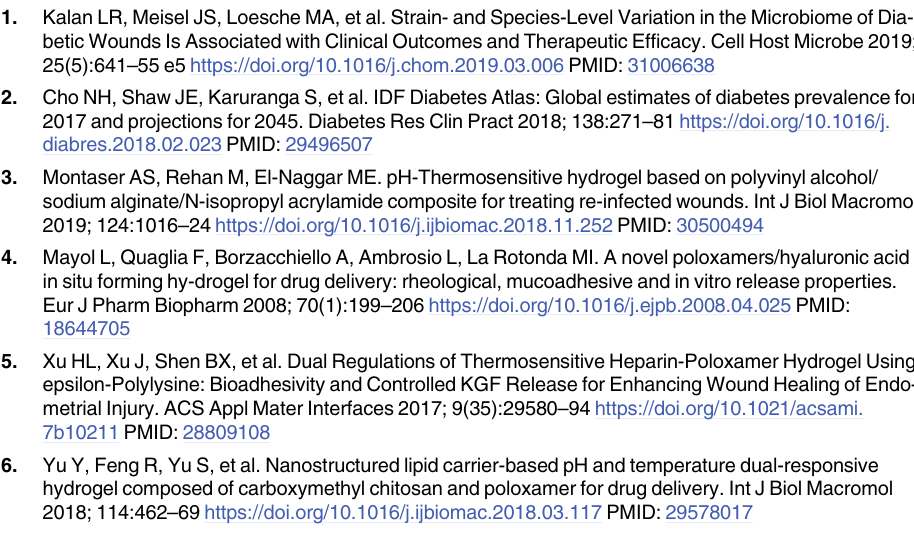
S1 Fig. All western blots in the article. The original images of western blots. (TIF) S2 Fig. The biocompatibility of the hydrogel. The comparison of wound skin stained with HE after using